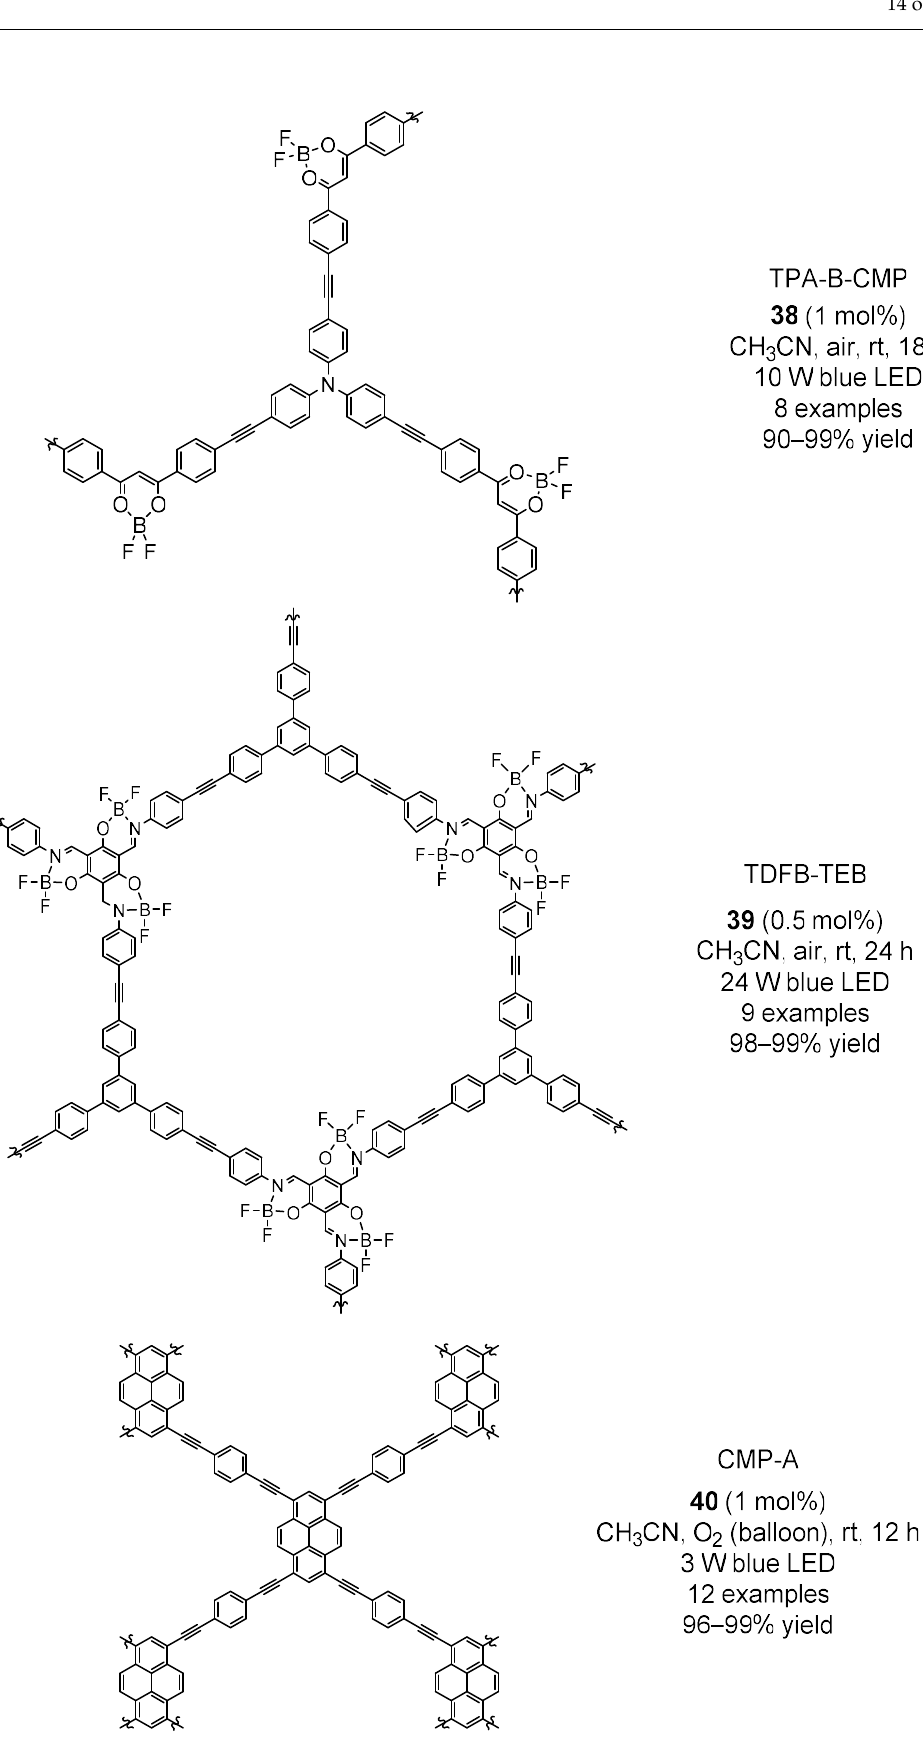
Figure 6. Results obtained in the aerobic photo-oxidative coupling of benzylamines to N -benzylidene benzylamines 2 catalyzed by 38 – 40 .